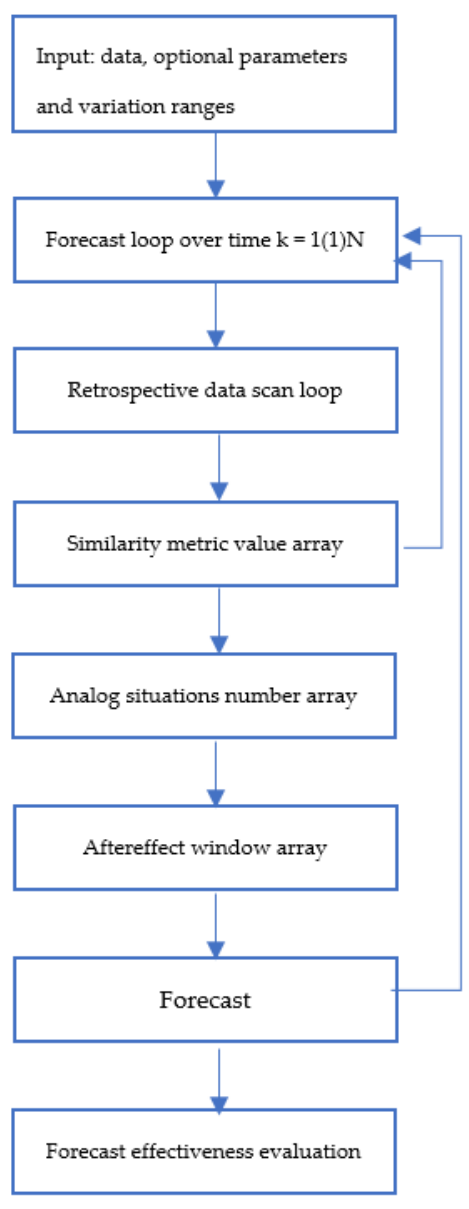
Figure 9. An implementation of precedent forecasting for a multidimensional chaotic process.